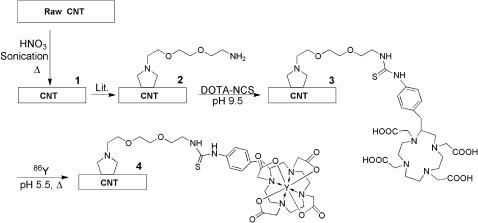
Synthetic scheme to prepare 86Y-CNT.